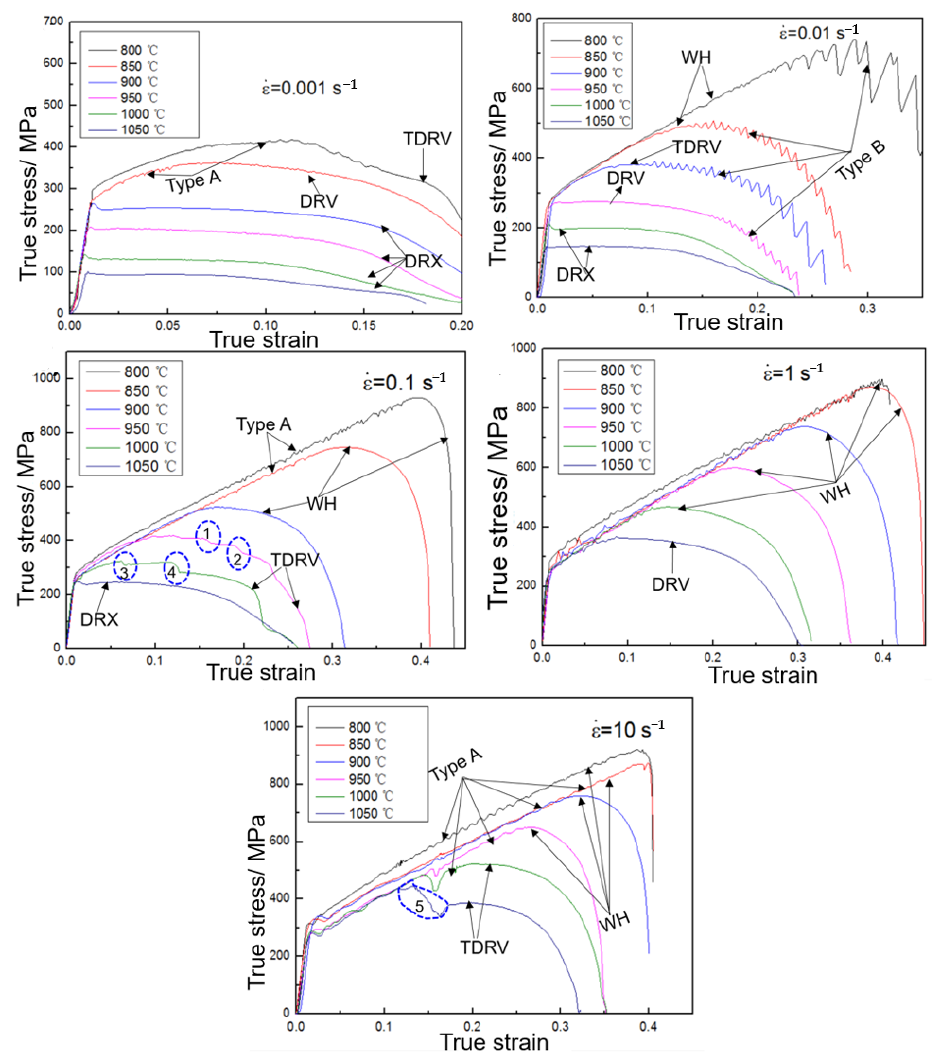
Figure 9. The true stress strain curves of the GH3625 superalloy at different strain rates. Every flow curve in Figure 9 is indicated by arrows as the corresponding type of curve (WH, TDRV, DRV and DRX). Serration flow during the hot tensile deformation of the GH3625 was observed at all flow curves except DRX curves, signifying the occurrence of dynamic strain ageing (DSA). DSA is caused by the interaction between solute atoms and mobile dislocations during straining [25]. The amplitude of variations for serration types A and B is around 10 MPa and 20 MPa, respectively. Moreover, a sharp drop in flow stress is also observed (indicated by circles 1~5), the decrease range is 18 MPa, 27 MPa, 11 MPa, 40 MPa and 100 MPa from circle 1 to circle 5, respectively. It is noteworthy that TDRV curves were characterized in the form of type A or type B or by a sharp drop in flow